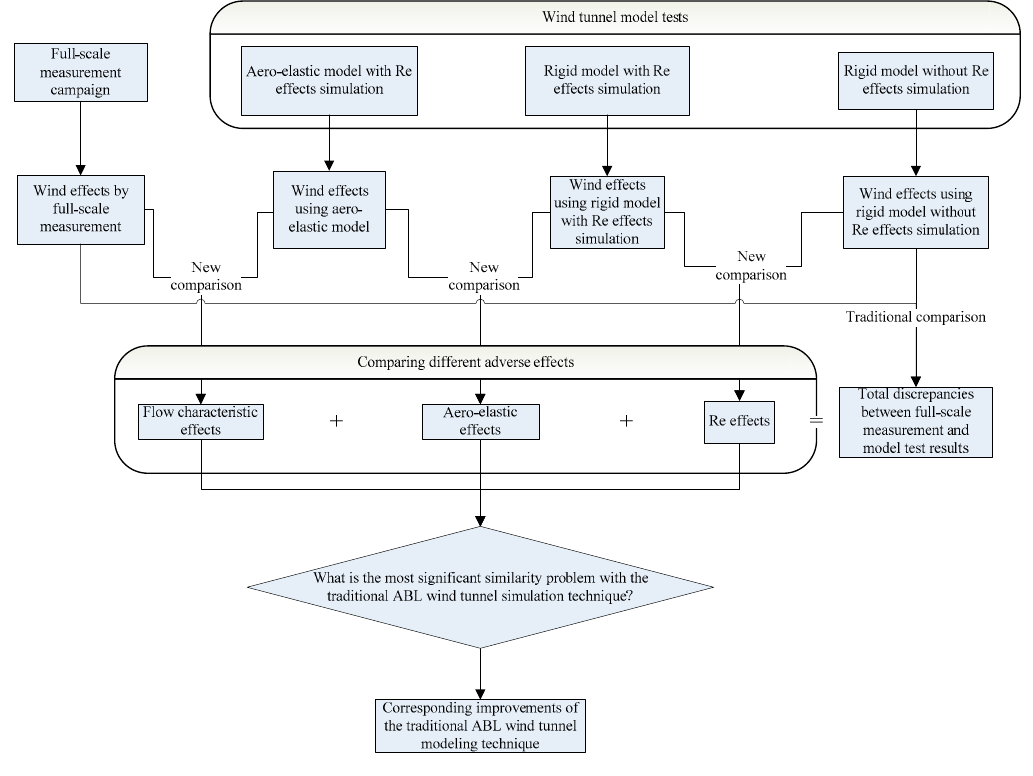
Figure 1. Flowchart of the new research scheme.